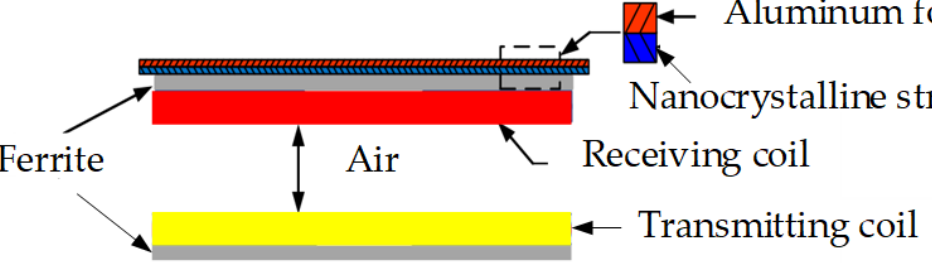
Figure 15. Composite shielding structure of magnetic coupler.